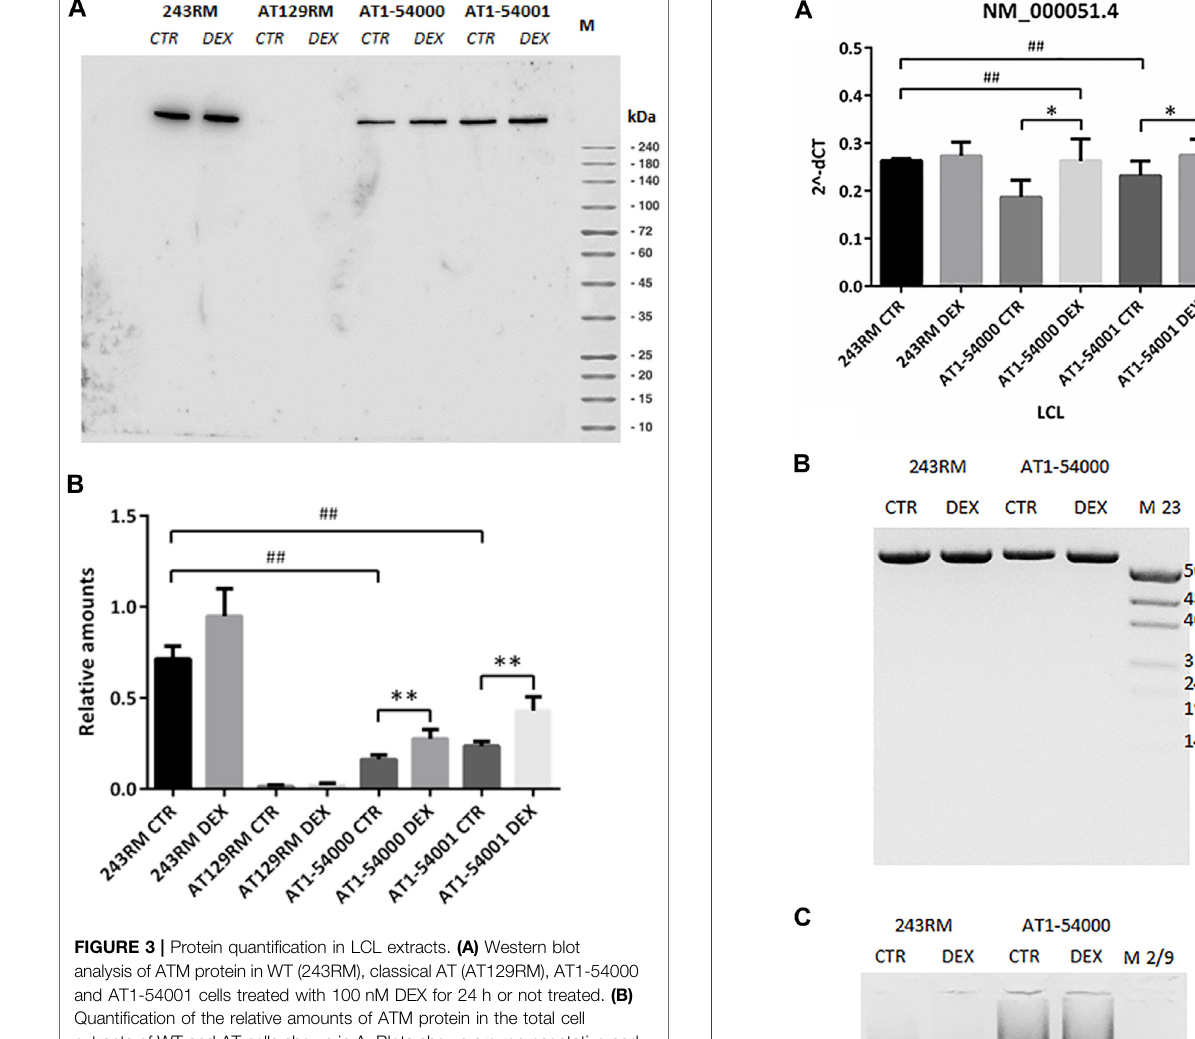
( Figure 2D ). The software also predicted “ Structural damage detected ” due to “ buried hydrophilic introduced ” and “ buried charge introduced. ”